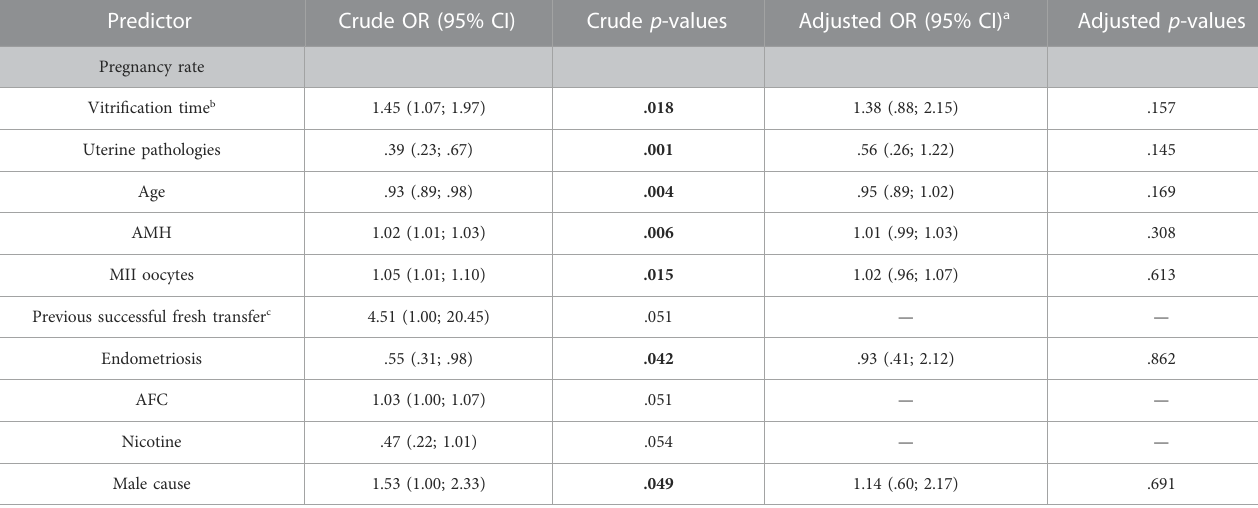
TABLE 8 Uni- and multivariate analysis with vitri fi cation time divided into three groups. Predictor Crude OR (95% CI) Crude p -values Adjusted OR (95% CI) a Adjusted p -values Pregnancy rate Vitri fi cation time b